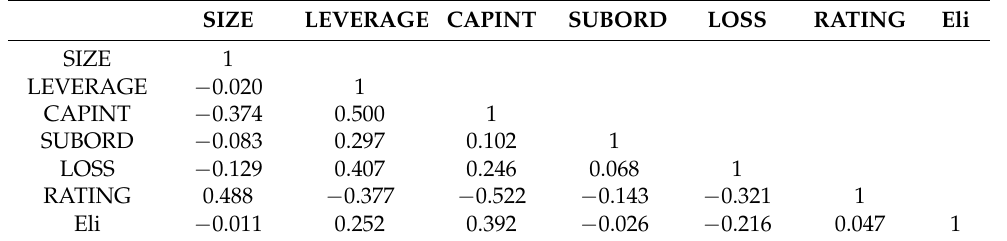
Table 4. Pearson correlation.